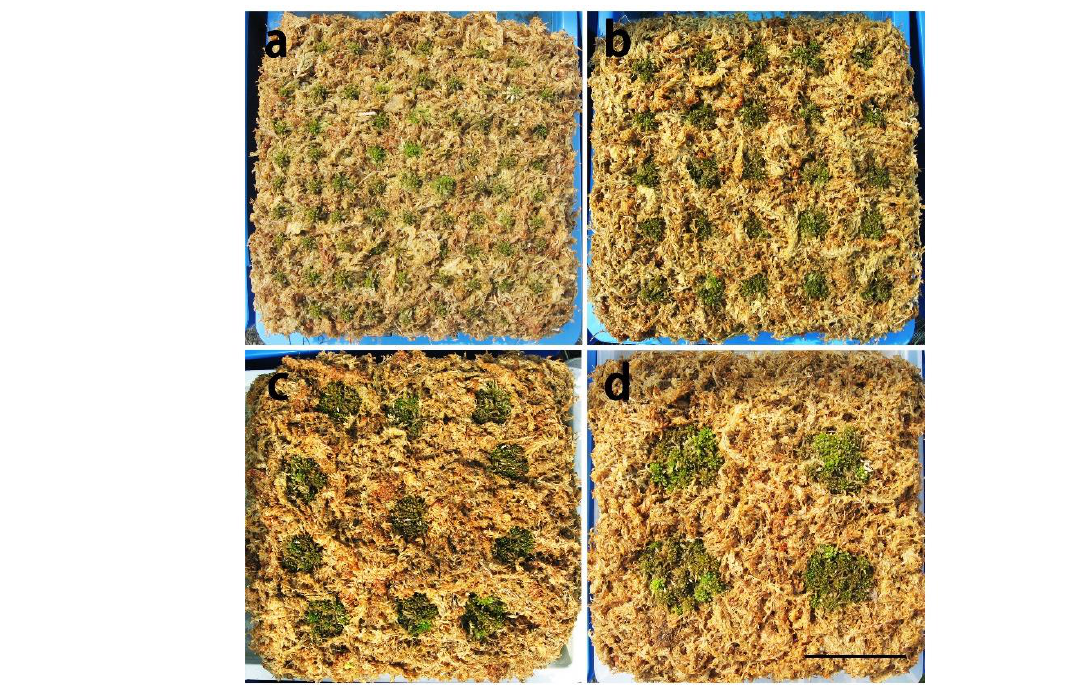
Figure 4. Example cultures with different sizes and numbers of Sphagnum colonies formed by planting live capitula, in the planting treatments ‘77×1cap’(a), ‘25×3cap’(b), ‘11×7cap’ (c) and ‘4×19cap’ (d). Scale bar = 10